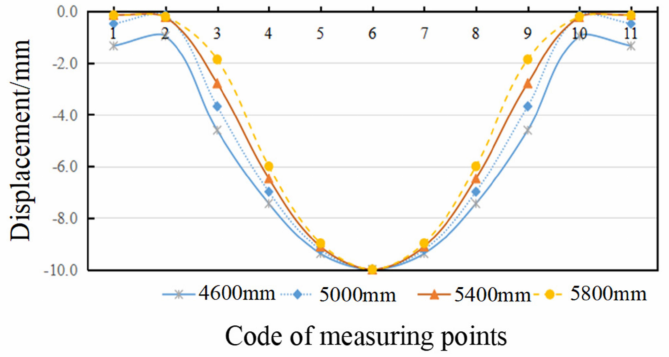
Figure 12. Track slab displacement curve under different length conditions.